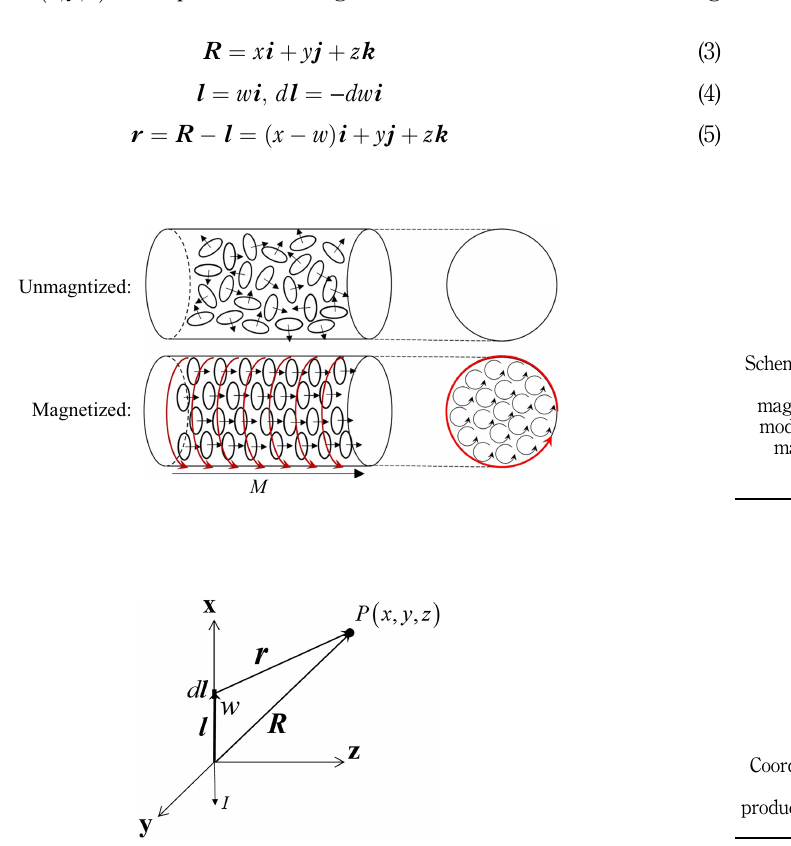
Figure 1. Schematic drawing of